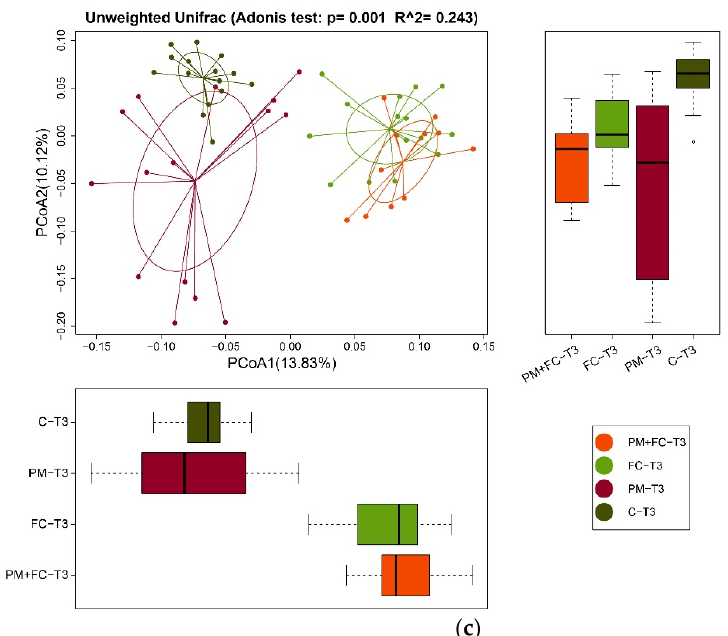
Figure 10. β diversity of gut microbiota at T1 ( a ), T2 ( b ), and T3 ( c ). The abscissa and ordinate represent the first and second principal coordinates, respectively; the percentage represents the contribution rate of the corresponding principal coordinate to the sample difference; and the p value is the test p value of the corresponding principal coordinate. The dots represent each sample, respectively, and different colors indicate that the samples belong to different groups. The horizontal box graph is the distribution of the values of different groups on the first principal coordinate; the vertical box graph is the distribution of the values of different groups on the second principal coordinate. The calculation process was implemented by the vegan package of the R language: 0.01 < p ≤ 0.05, indicating significant difference; p ≤ 0.01, indicating an extremely distinct difference.